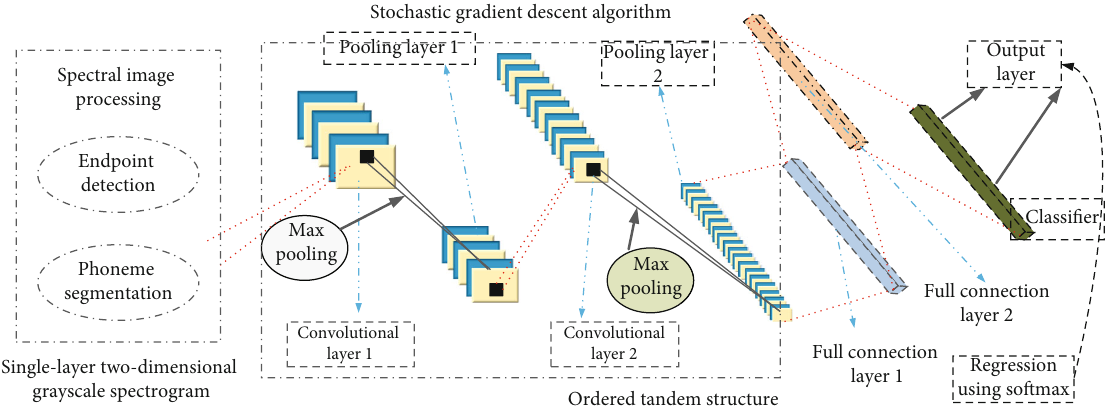
Figure 1: Structure diagram of the CNN model used in this